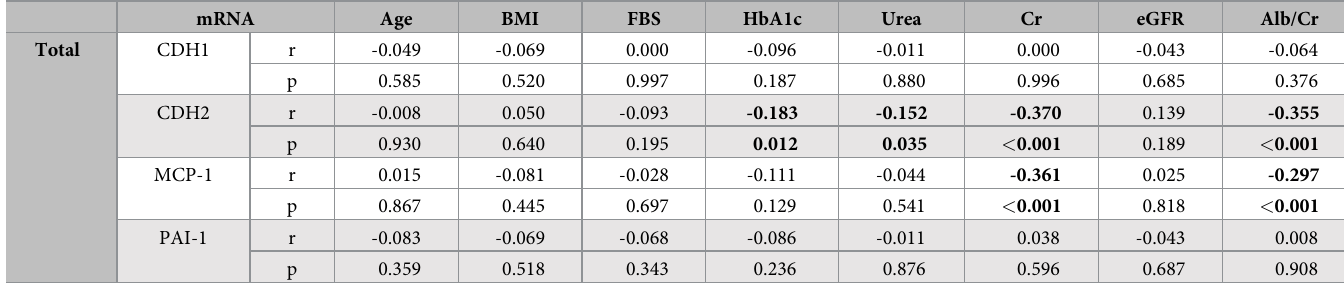
Table 5. Correlations of CDH1, CDH2, MCP-1, and PAI-1 mRNAs with demographic data and clinical laboratory tests in all participants.